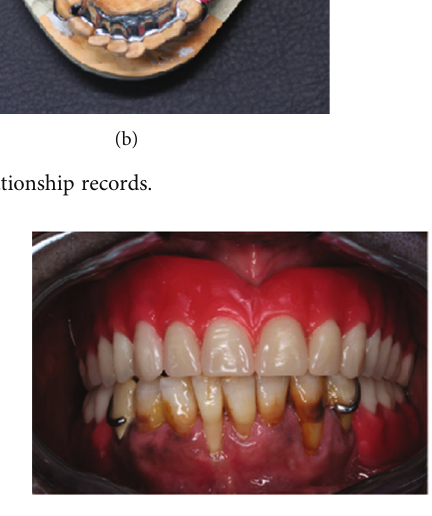
Figure 24: Teeth set up and